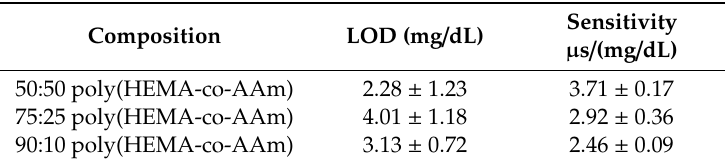
Table 3. Key metrics for biosensor compositions. Each value is an average of three samples ± 95% confidence